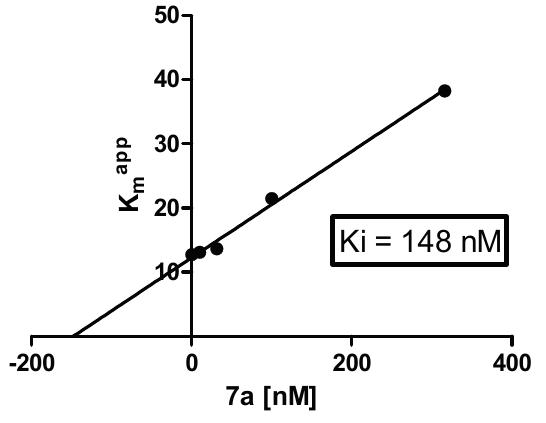
Figure 5. The two most potent CK2 inhibitors 5a and 7a of the novel indeno[1,2- b ]indole derivatives.